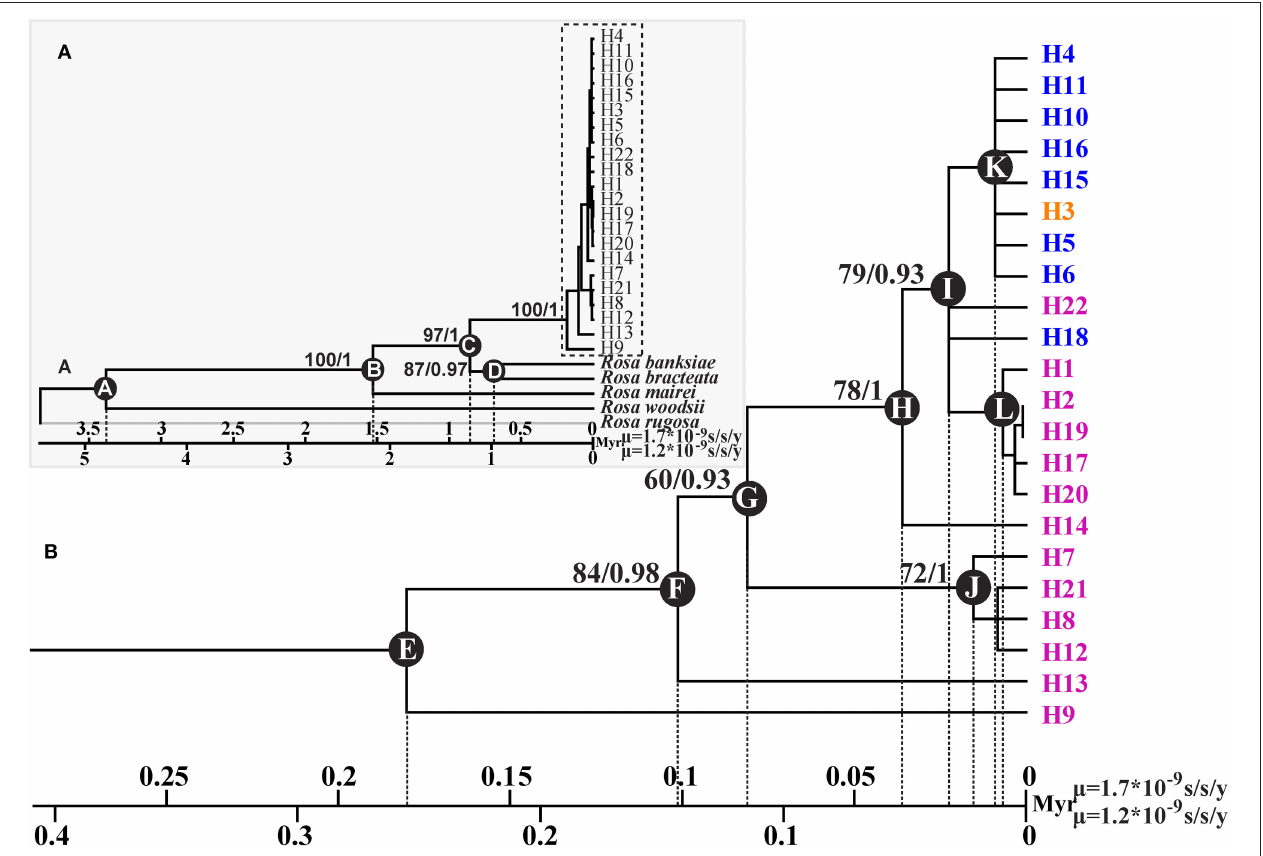
FIGURE 3 | Phylogenetic tree and divergence time estimates of cpDNA haplotypes of R. chinensis var. spontanea - Rosa lucidissima complex. Part A showed the phylogenetic relationship and divergence time between the complex and the outgroup species, while part B showed those within the complex. Rosa lucidissima haplotypes are in pink, R. chinensis var. spontanea ones in blue, and the shared ones in orange. Bootstrap values (%) (ML) and the posterior probability values (BI) are indicated above the branches. The estimated divergence time among the outgroup species, between the complex and outgroups, and for the complex clades are indicated at nodes: A (3.38–4.79 Mya), B (1.53–2.16 Mya), C (0.86–1.21 Mya), D (0.68–0.95 Mya), E (0.18–0.25 Mya), F (0.1–0.14 Mya), G (0.08–0.11 Mya), H (0.036–0.05 Mya), I (0.02–0.03 Mya), J (0.01–0.02 Mya), K (0.008–0.01 Mya), L (0.006–0.008